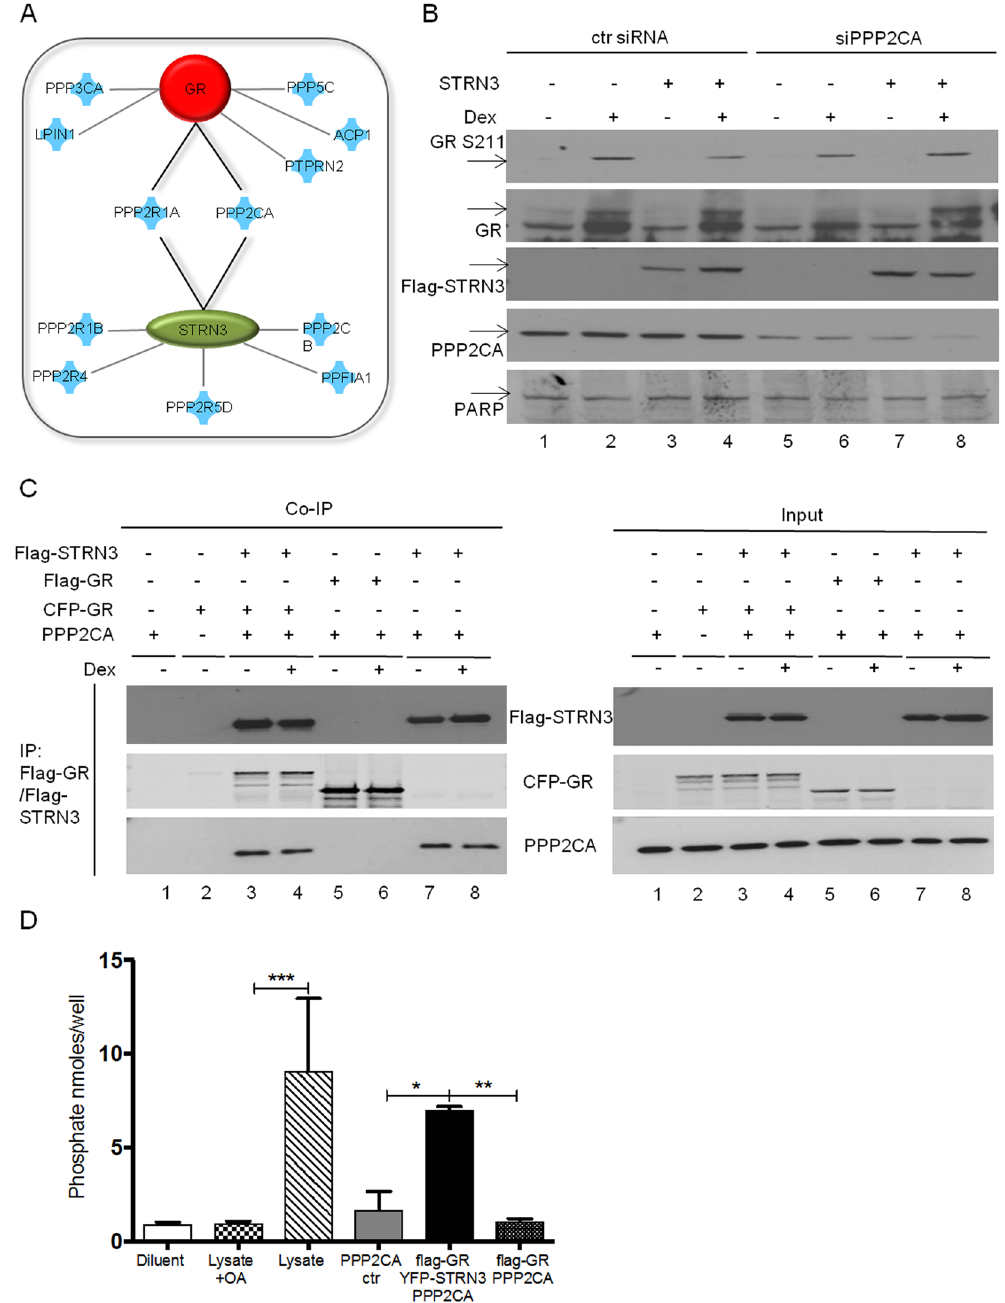
Figure 7. PPP2CA mediates the effect of STRN3 on GR phosphorylation. ( A ) Identification of common interacting phosphatases for STRN3 and GR using Ingenuity Pathway Analysis (IPA) database. ( B ) A549 cells were transfected in 10 cm plates with 50 nM of control (lanes 1–4) or with PPP2CA (lanes 5–8) siRNA. After 24 h, Flag-STRN3 (lanes 3–4, 7–8) or mock (lanes 1–2, 5–6) plasmids were over-expressed (6 μ of total DNA was transfected per plate). After 48 h, the cells were treated with vehicle or 1 μ M Dex for 2 h and lysed. The nuclear fractions of the lysates were analyzed by immunoblotting against GR phosphorylated at S211, total GR (86 kDa), (Flag-) STRN3 (96 kDa), PPP2CA (35 kDa) and PARP (116 kDa, nuclear marker). Total GR expression was identified in a separate immunoblot to avoid multiple stripping of the membrane. This is a representative experiment out of three independent experiments that have been performed with similar results. ( C ) Co-immunoprecipitation experiment in HEK293T cells for the complexes GR/STRN3/PPP2CA, GR/PPP2CA and STRN3/PPP2CA (in 10 cm plates). Over-expression of 4 μ g PPP2CA (lane 1) and over- expression of 4 μ g CFP-GR (lane 2) serve as negative controls. Additionally, the cells were transfected with 3 μ g Flag-STRN3, 4 μ g CFP-GR and 4 μ g PPP2CA (lanes 3–4) or with 3 μ g Flag-GR and 4 μ g PPP2CA (lanes 5–6) or with 3 μ g Flag-STRN3 and 4 μ g PPP2CA (lanes 7–8). 48 h after transfection, the cells were treated with vehicle or with 1 μ M Dex as indicated (2 h). The lysates were used for IP assays using M2-Flag beads and